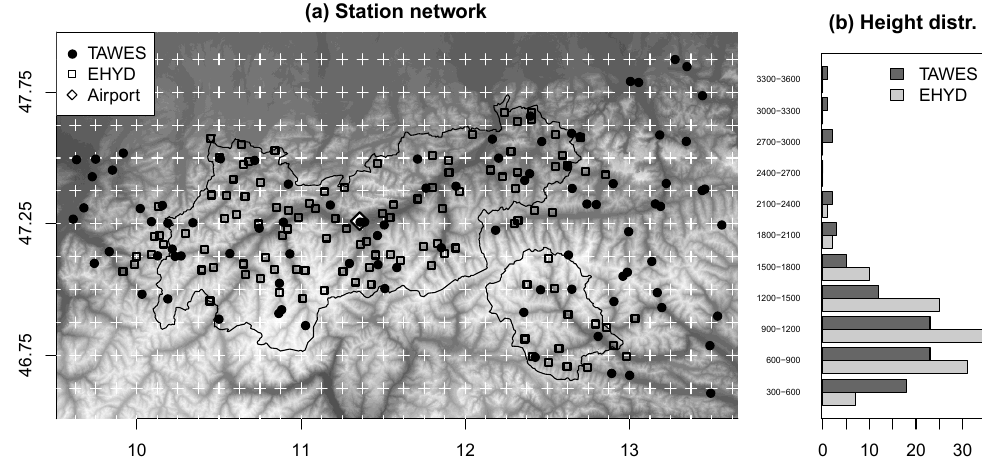
Figure 1. Panel (a) shows the topography of the area of interest. Overlays: center of the grid cells of the NWP model data (white crosses), governmental area of Tyrol (black outline), location of the TAWES stations (89; circles) and EHYD stations (110; squares). The airport is indicated by a diamond in the center of the map. Panel (b) shows the height distribution of the stations grouped into 300m intervals: number of stations (abscissa) and altitude intervals (ordinate; meters